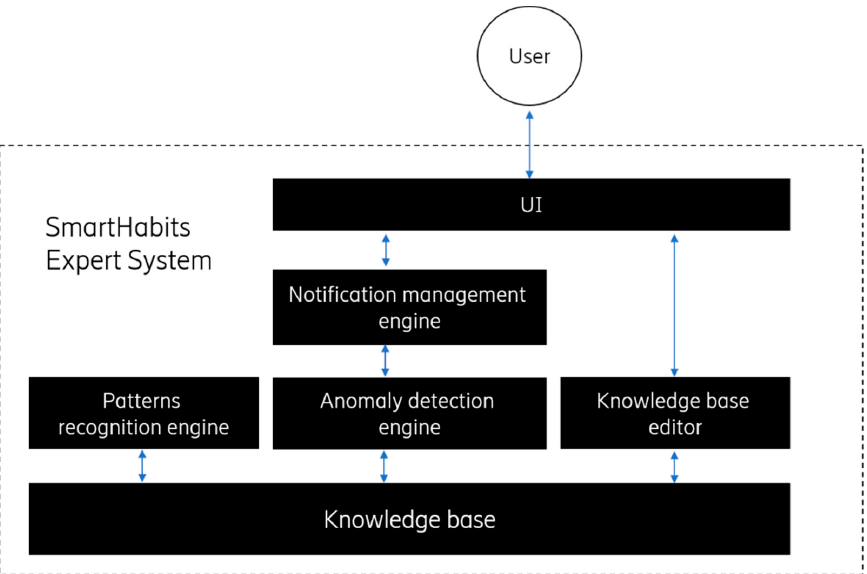
Figure 2. The SmartHabits expert system.